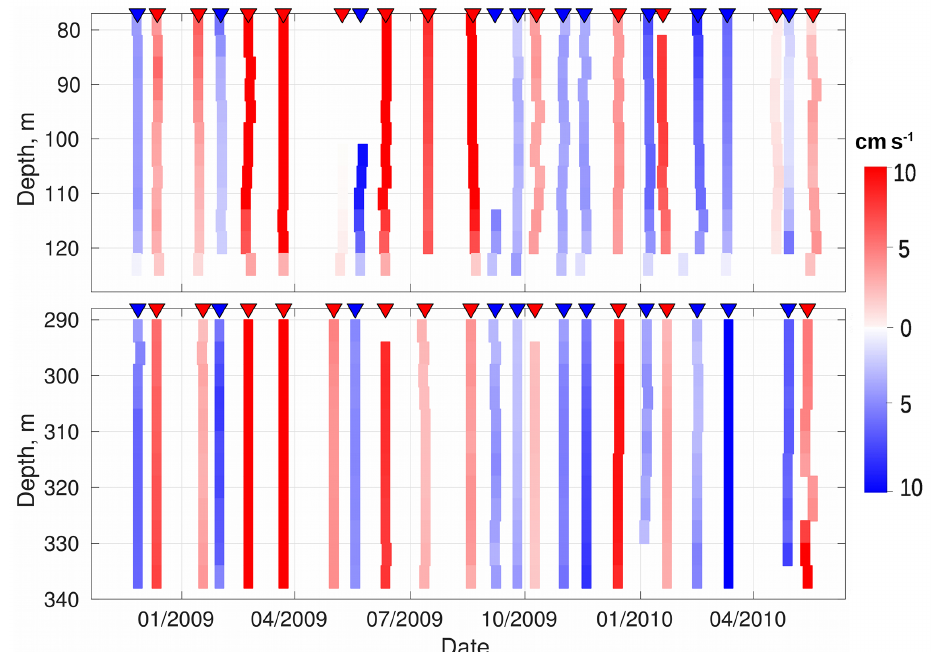
Figure 5. Results of wavelet-based identification of eddies using two ADCP records at the M1g mooring over the Laptev Sea continental slope in 2009–2011. Each vertical color stripe represents a single eddy. Red is used for anticyclonic rotation; blue is used for cyclonic rotation. Color intensity shows the rotational speed of eddies (cms − 1 ). Color triangles on top of each panel indicate the time when an eddy “pseudo” center passes the mooring